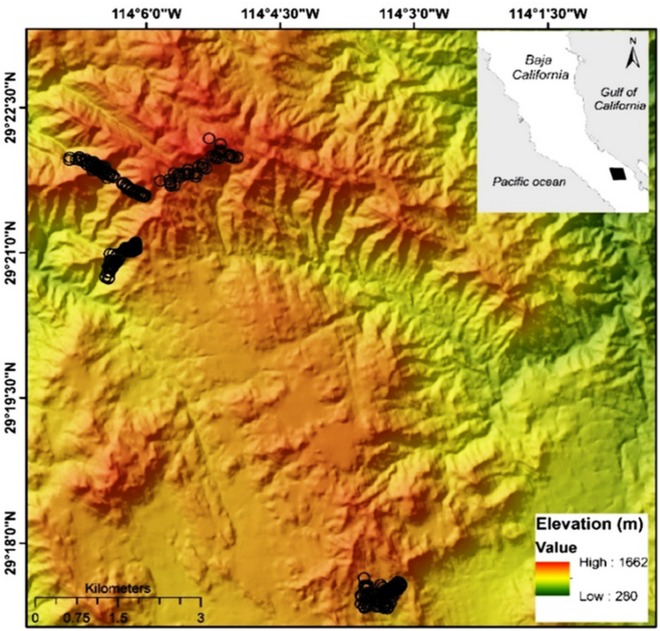
Map of Sierra La Asamblea.The black circles indicate georeferenced sites occupied by Pinus monophylla.